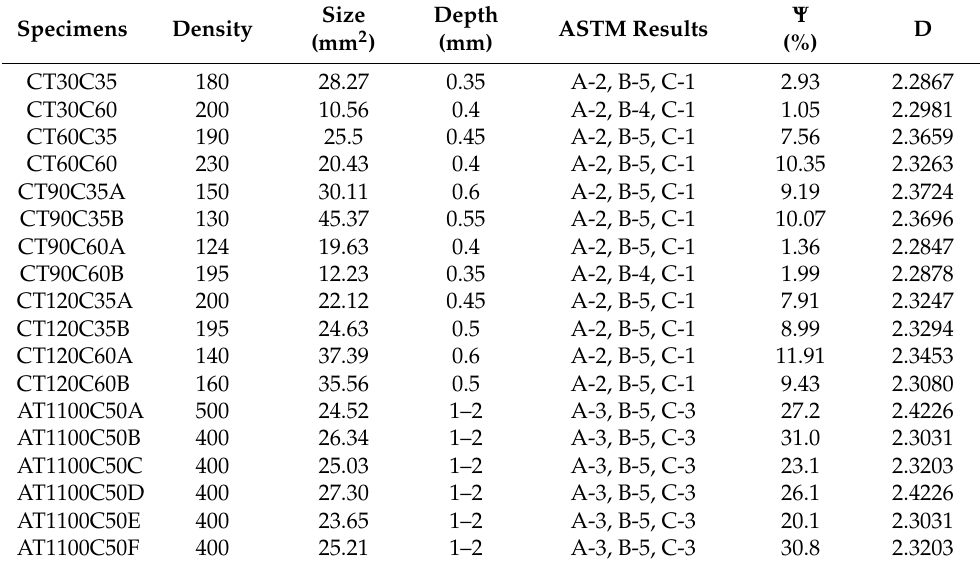
Table 4. Corrosion evaluation of